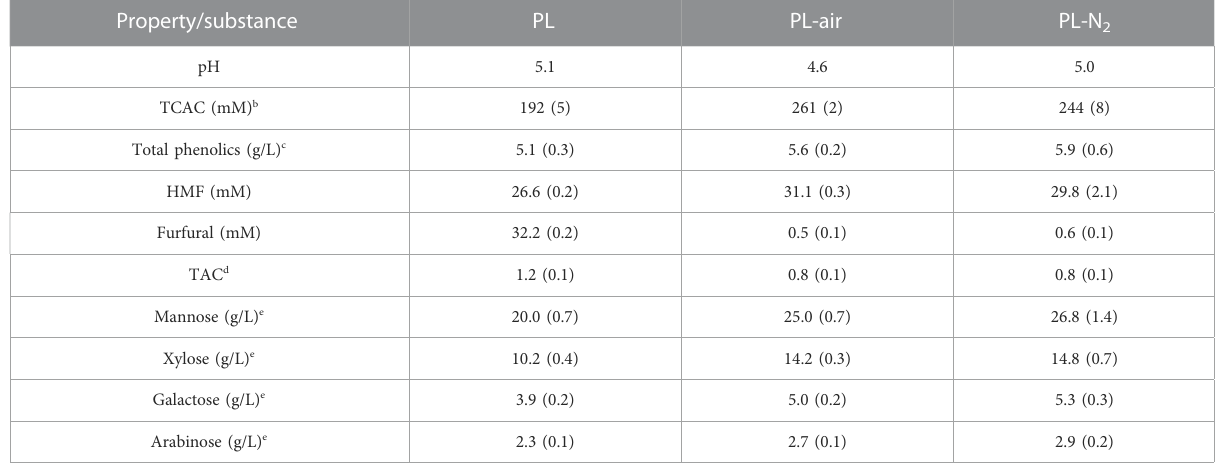
TABLE 2 Analysis of pH-adjusted pretreatment liquid and the liquid phases after 72 h sacchari fi cation. a Property/substance PL PL-air